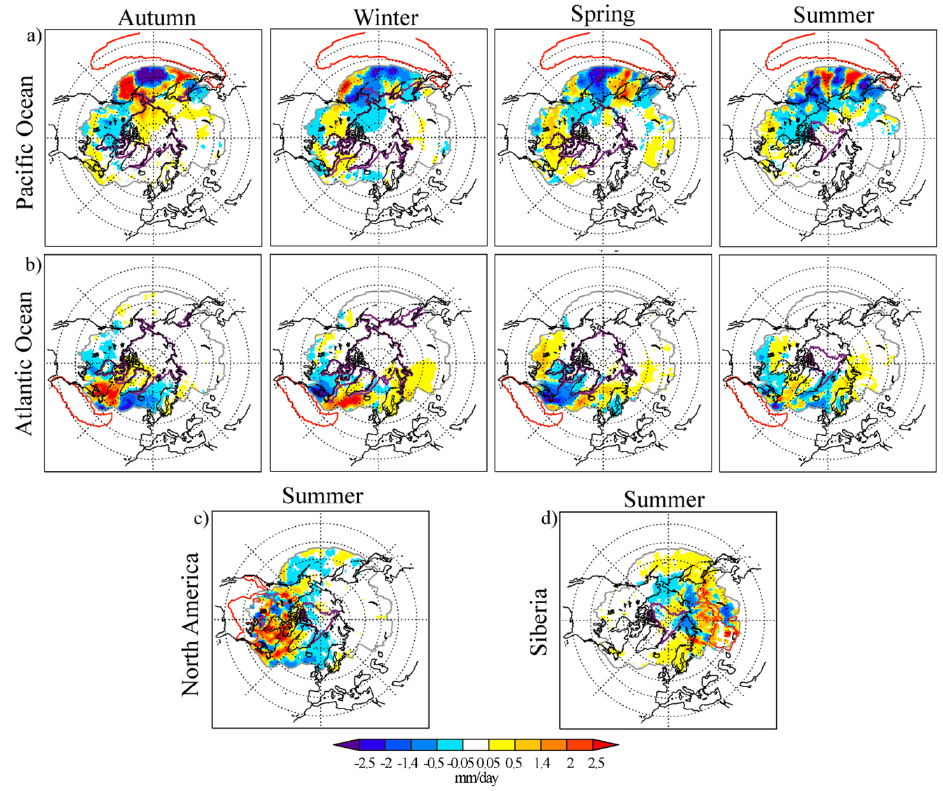
Figure 6. Seasonal (E–P) < 0 anomalies for 2006/2007 in the forward experiment from ( a ) the Pacific Ocean ( b ) the Atlantic Ocean ( c ) North America and ( d ) Siberia. Reddish colours represent areas over which the moisture supply is greater that year from the selected source (positive anomalies) and bluish colours represent areas where the moisture uptake is lower that year (negative anomalies). Red contour lines represent climatological moisture sources for the Arctic system. Purple contour lines represent the sea ice extent at the end of every season.